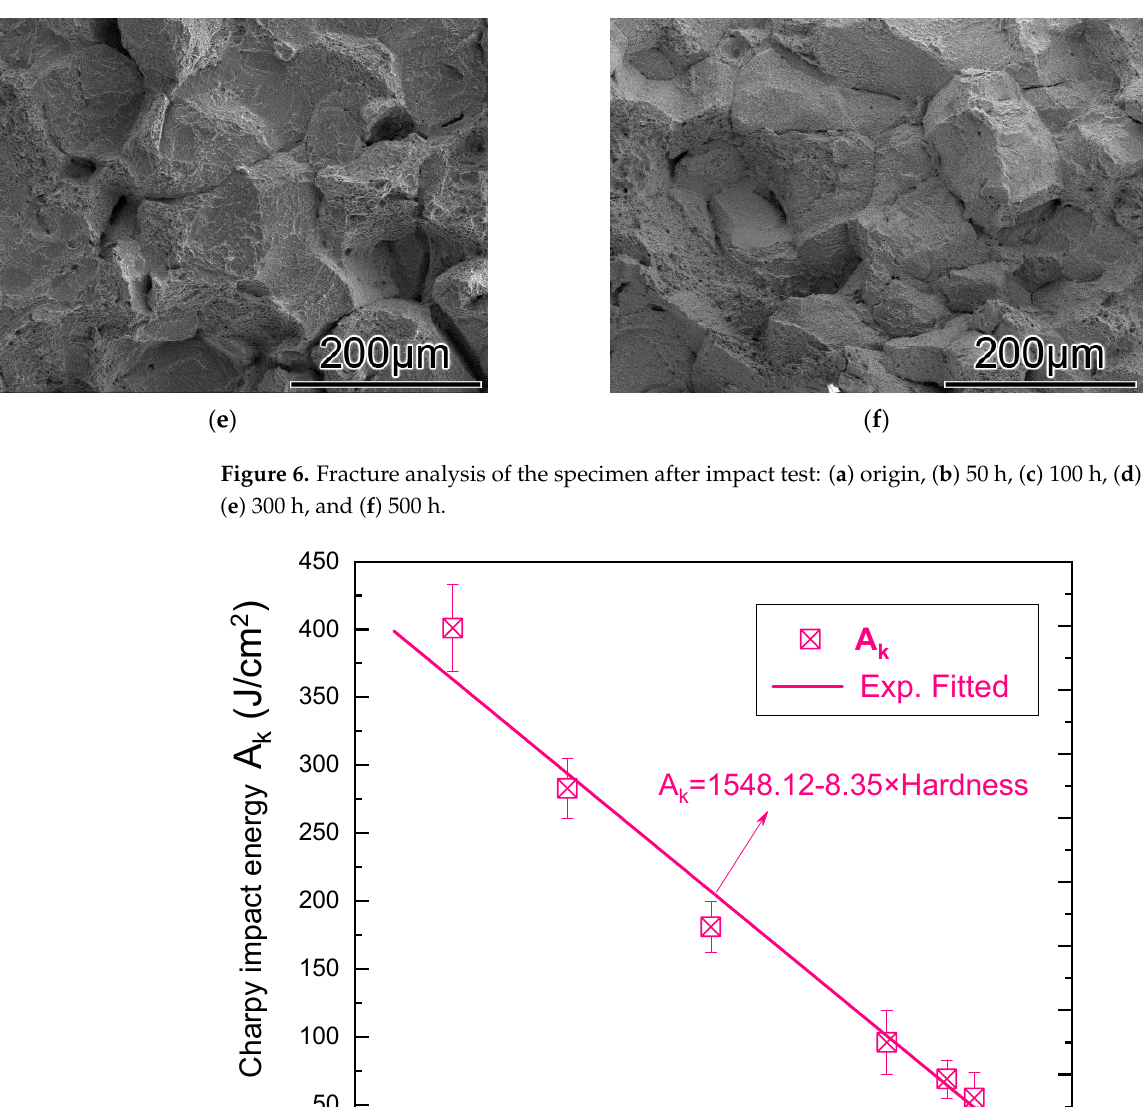
Figure 7. Relationship between Charpy impact energy and Brinell hardness value after aging at 750 °C .